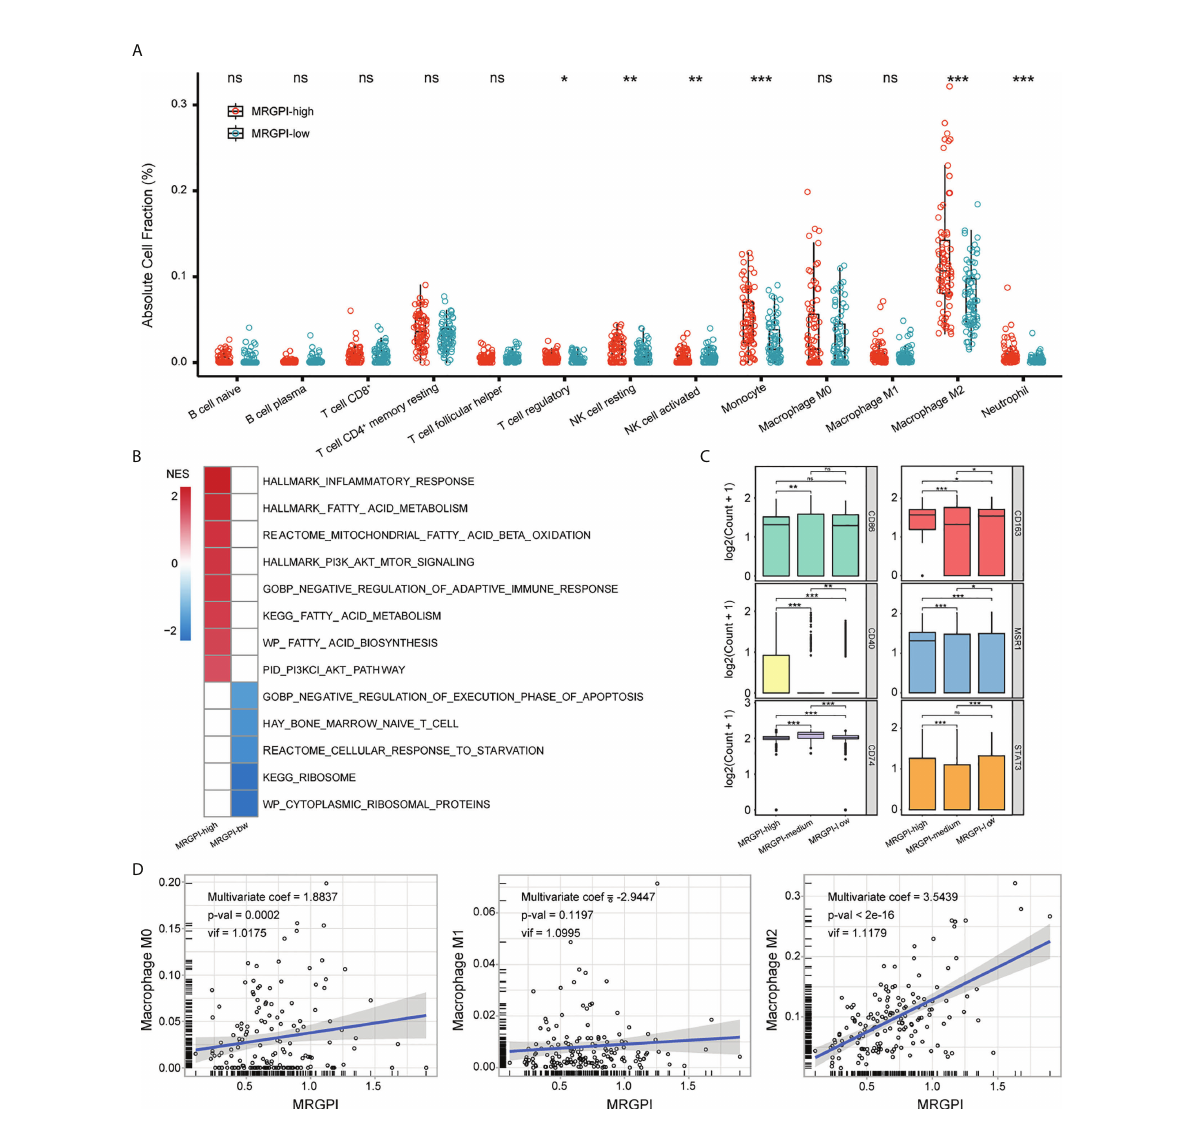
FIGURE 4 Immune characteristics of MRGPI groups. (A) The fraction of immune in fi ltration was estimated by CIBERSORT. (B) GSEA analysis of pathways enriched in each group based on the expression pro fi le of the Mono/Macro subcluster. Pathways with FDR-q < 0.1 were exhibited. The color (red or blue) was proportional to the NES of the corresponding pathway in MRGPI-high or -low groups. (C) The expression of macrophage biomarkers in MRGPI-based groups. Mono/Macro subcluster was split into -high, -medium, and -low groups by the MRGPI. (D) Correlation between the MRGPI and different macrophages at the bulk-tumor level. *p < 0.05, **p < 0.01, ***p < 0.001. ns, non signi fi